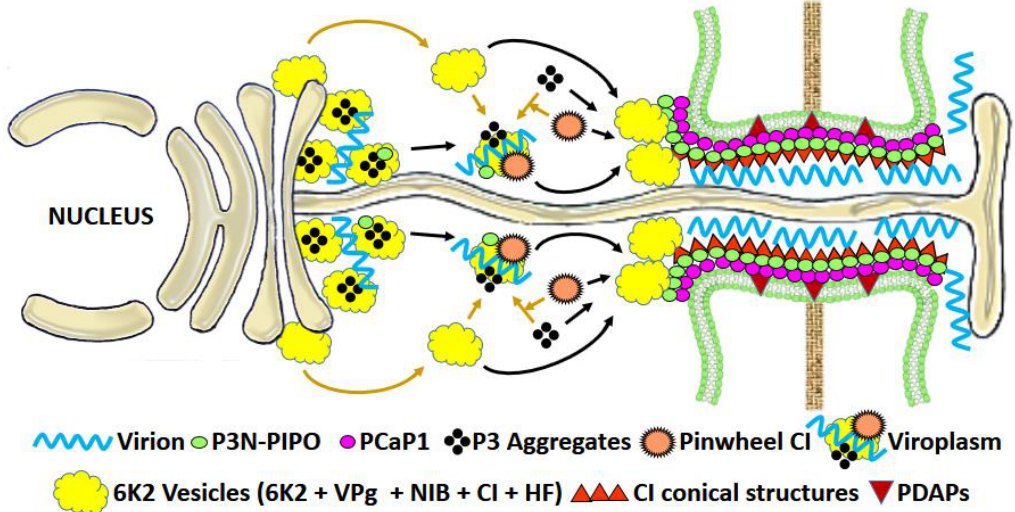
Figure 4. Model for movement of TuMV: The TuMV virion movement involves a multifaceted interaction between virus- encoded proteins 6 K2, VpG, NIb, CI and P3N-PIPO and host-encoded PM localized Ca 2+- binding protein PCaP1. The TuMV MP P3N-PIPO interacts with PCaP1 for its localization to PD. After translation, the virus-encoded proteins for replication along with the assisting host proteins get assembled into clusters of 6 K2 vesicles. The ER-derived P3 aggregates interact with 6 K2 via the P3C domain and accumulate in the 6 K2 vesicle cluster. Along with PD, the P3N-PIPO also localizes to the 6 K2 clusters via P3. The CI also gets recruited to two sites- the PD, by interaction with P3N-PIPO-associated with PCaP1 at PD and-6 K2 clusters by interaction with P3-colocalized P3N-PIPO where probably they participate in replication. The PD recruited CI forms a CI-P3N-PIPO complex to which more CI molecules join via self-interaction resulting in the formation of conical structures. The CI also self-integrates to form a cytosolic pinwheel-like structure. The CK2 vesicle cluster either combines with CI, P3 and P3N-PIPO to form a virus-induced cytosolic viroplasm or is directly delivered to PD and docked at the P3N-PIPO-associated conical CI structures. Upon reaching the PD, the viral RNA is encapsidated by CP to form an intact virion or RNP complex, which is delivered to the neighboring cell by the CI. Adapted and modified from